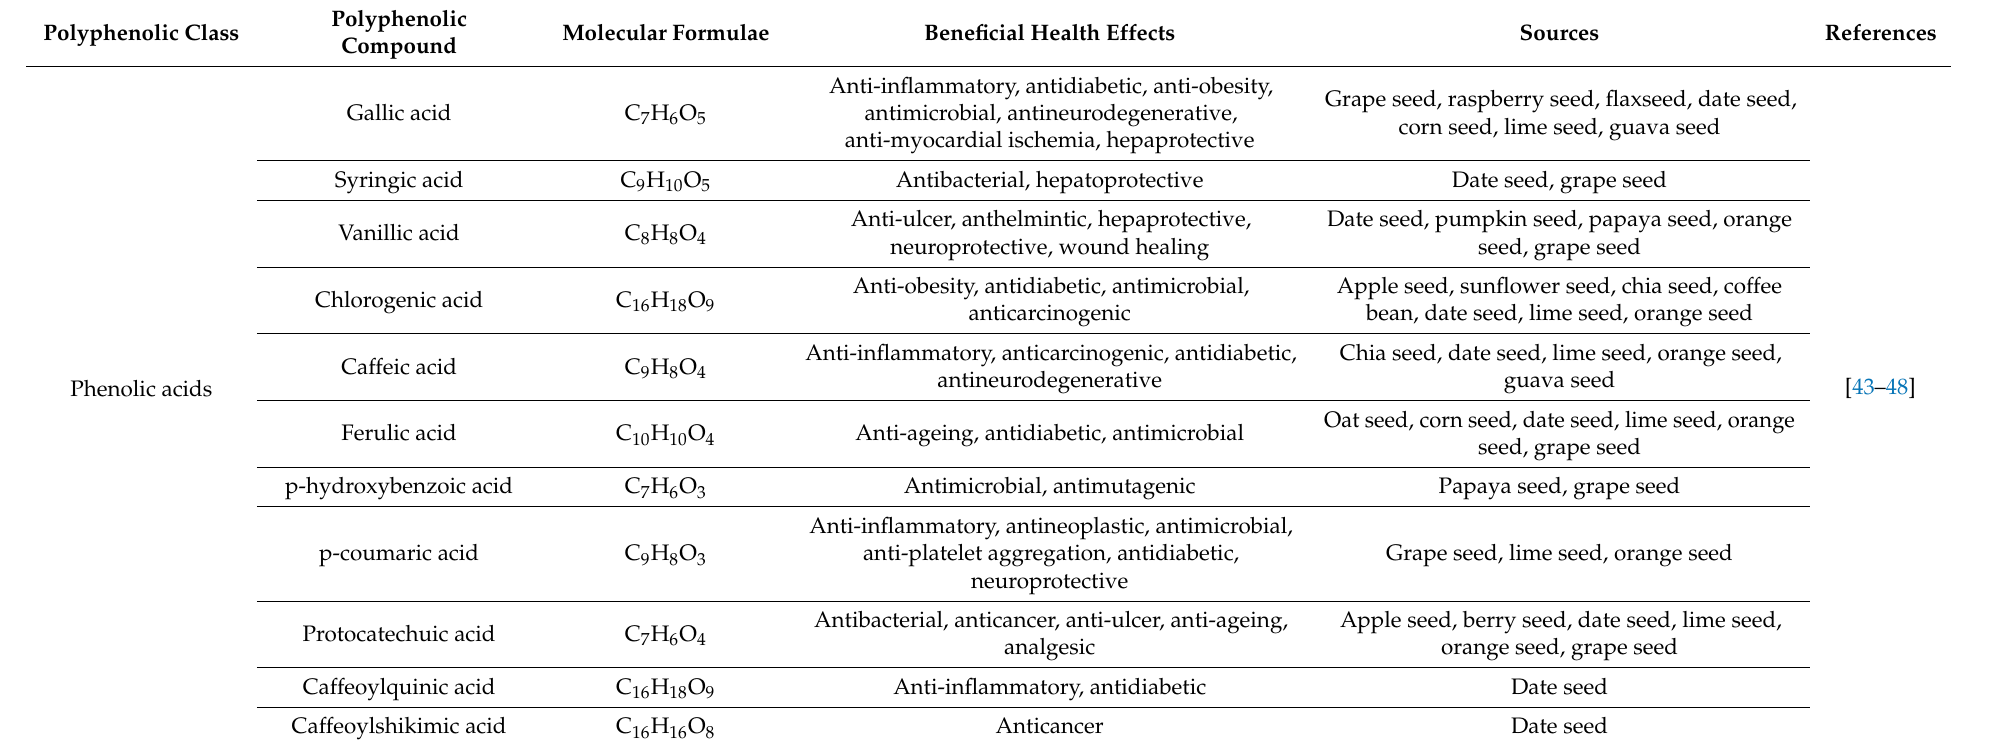
Table 1. Major classes of polyphenols, selected polyphenolic compounds, and their beneficial health effects, obtained from underutilized